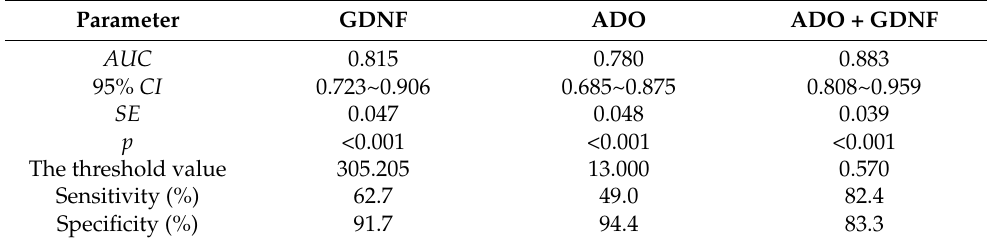
Figure 5. ROC curves of ADO and GDNF. Table 7. ROC analysis of ADO and GDNF.